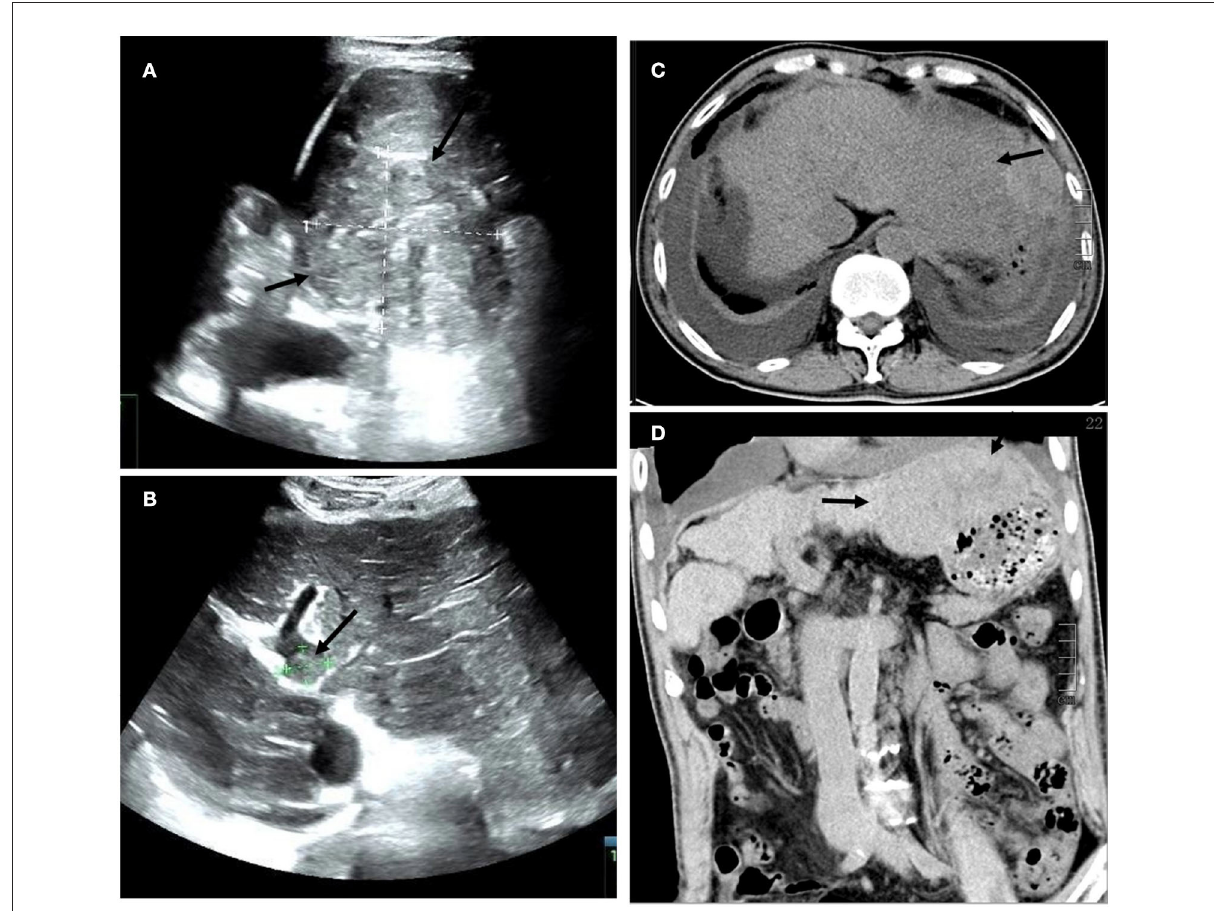
FIGURE1 (A) Transverse ultrasound (US) images of a large hypoechoic lesion with an irregular border and non-uniform internal echoes in the left lobe of the liver. Additionally (B) there is a filling defect approximately 1.7cm in diameter within the trunk of the portal vein (arrow). (C) Axial and (D) coronal plain abdominal CT scans revealed a decompensated period of cirrhosis, a lobulated and inhomogeneous mass with a slightly lower density in the left lobe, measuring 13.5cm x 6.8cm, and the presence of ascites and bilateral pleural effusion